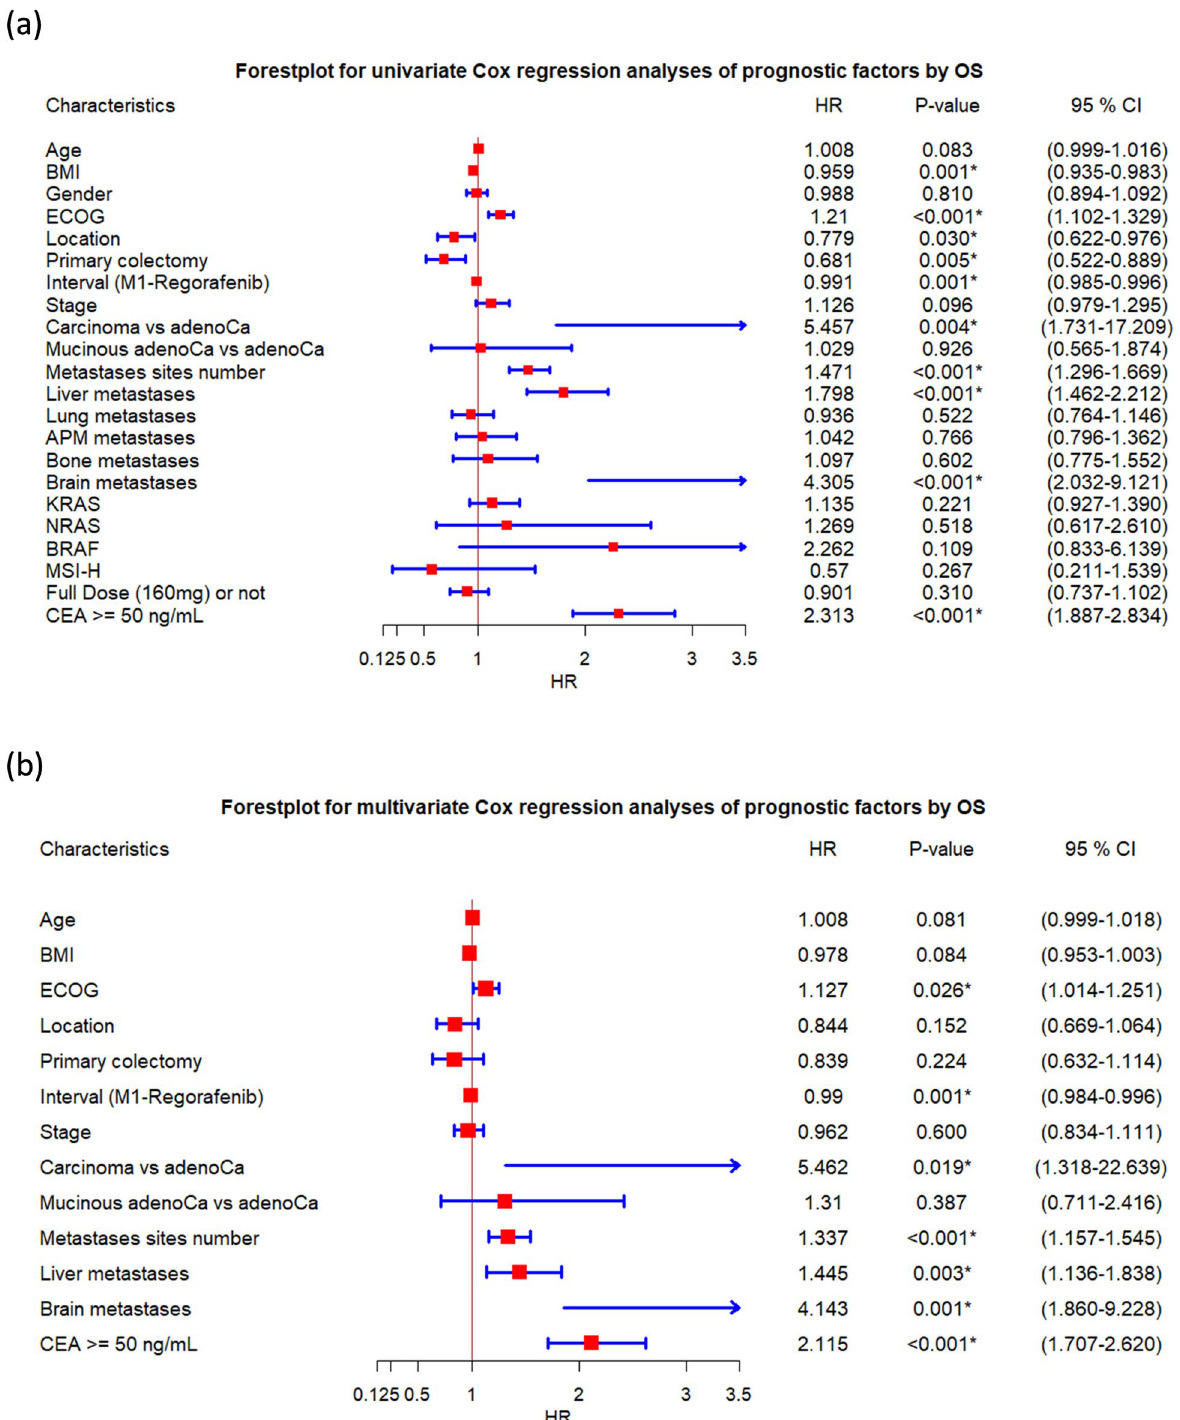
Figure 3. The forest plots present the ( a ) univariate and ( b ) multivariate analyses of prognostic factors in predicting overall survival (OS). Abbreviation: APM, abdominal/peritoneal